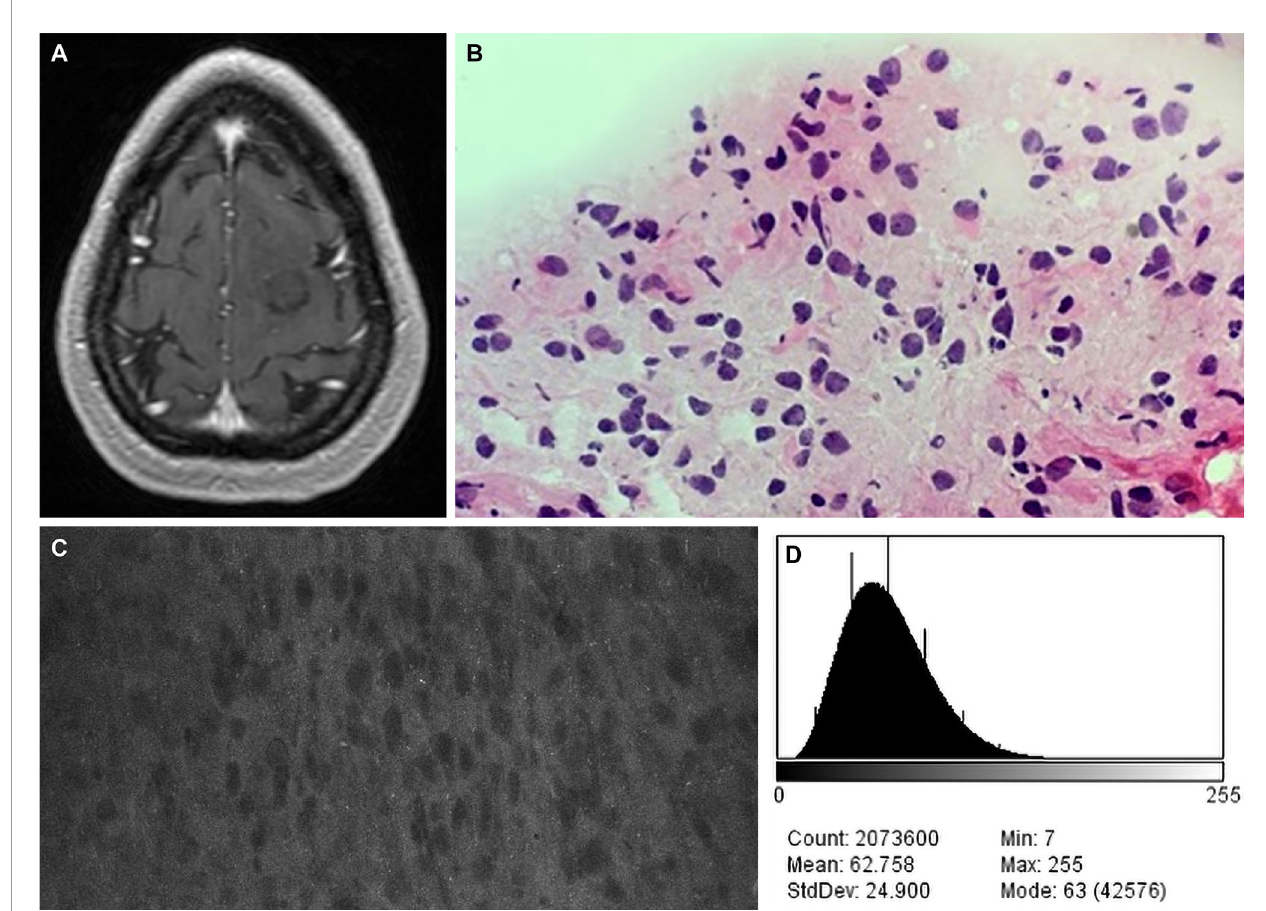
FIGURE 7 | Case example of CLE images acquired at a fl uorescein sodium (FNa) dose of 40 mg/kg. (A) Axial T1-weighted magnetic resonance image with contrast. Biopsy specimens were obtained from the nonenhancing tumor in the left frontal lobe. (B) A diagnosis of low-grade glioma was made on the basis of H&E staining of biopsy specimens. (C) A CLE image acquired 90 minutes after FNa injection appears to be relatively dark, but tumor cells are still present. (D) A corresponding histogram shows the intensity values of the CLE image. Count, number of pixels; Mean, brightness; StdDev, contrast; Min and Max, minimum and maximum gray values within the image; Mode, most frequently occurring gray value within the selection corresponds to the highest peak in the histogram. Used with permission from Barrow Neurological Institute, Phoenix, Arizona